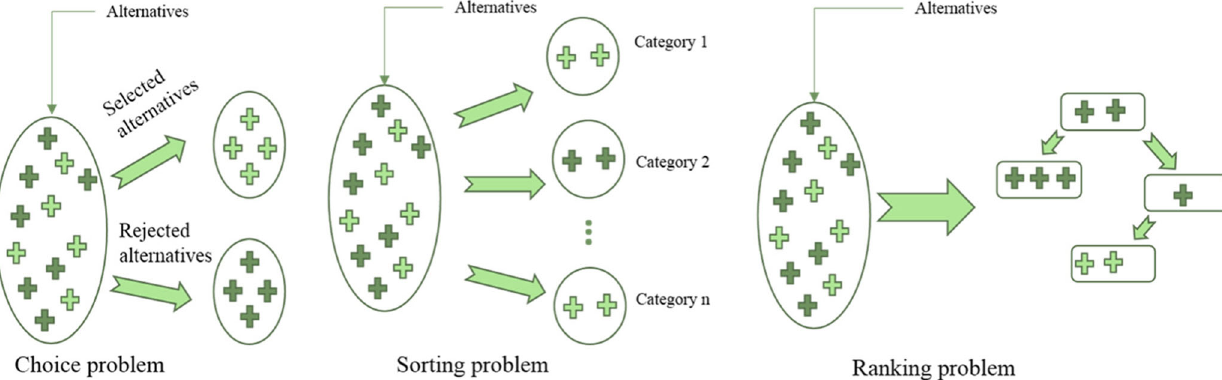
Fig. 2 MCDA problematic